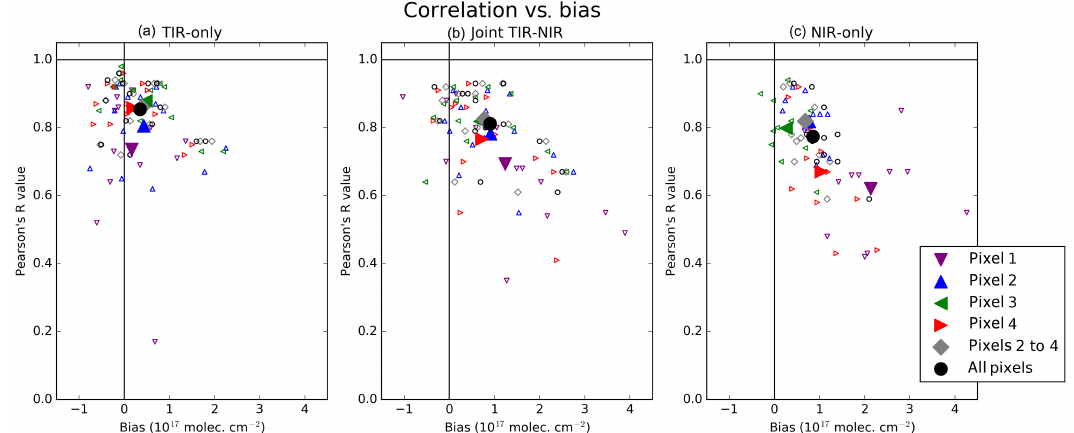
Figure 5. Pixel-wise validation results (correlation and bias) for each retrieval type at all FTS sites. Open markers represent results at each station and filled markers represent the mean value of all stations. The solid lines indicate zero bias and unity correlation. Columns are for the different MOPITT data products – (a) TIR-only, (b) TIR–NIR, and (c)